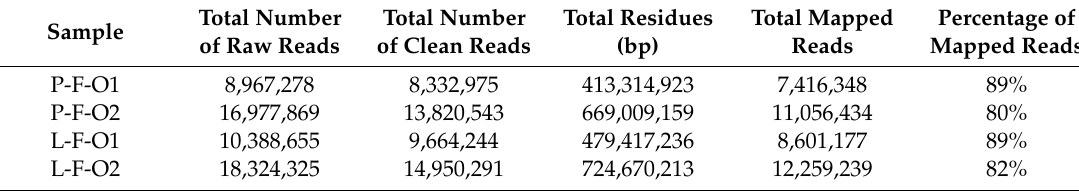
Table 1. Data generated from digital gene expression (DGE) RNA sequencing.